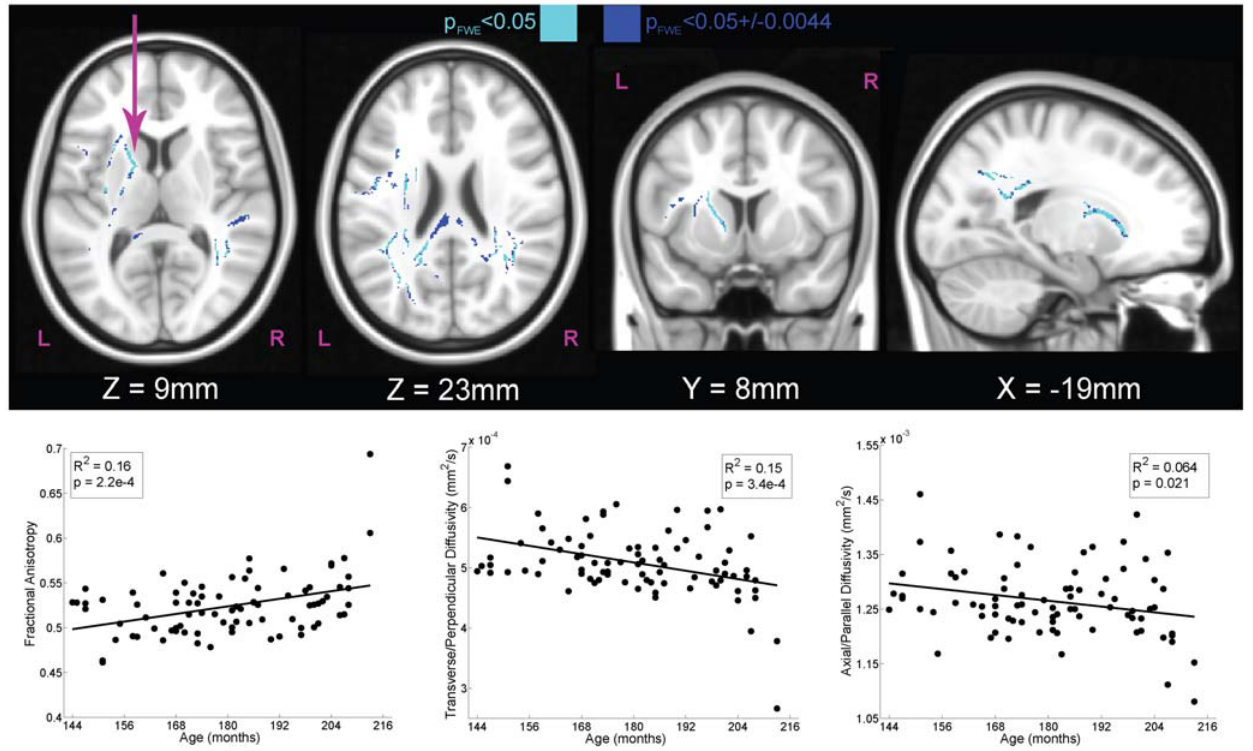
Figure 2. White matter tracts with significant correlations of DTI components to chronological age (N=83). Using the map for transverse diffusivity (TD), we used tract-based spatial statistics to identify regions within skeletonized white matter tracts that were significantly correlated with age. The maps were fully-corrected for familywise error (FWE) and thresholded at P , 0.05 ( light blue ). Because significance was determined using a permutation test based on 10,000 samplings of the dataset, the exact level of significance had a margin of error. The 95% confidence interval on this statistic ( 6 0.0044) is also shown ( dark blue ). The scatter plots illustrate the relationship between participant age and component DTI measures for the left anterior internal capsule ( arrow ). Increasing chronological age was associated with increases in fractional anisotropy (FA), which was due primarily to a decrease in TD ( middle bottom ).